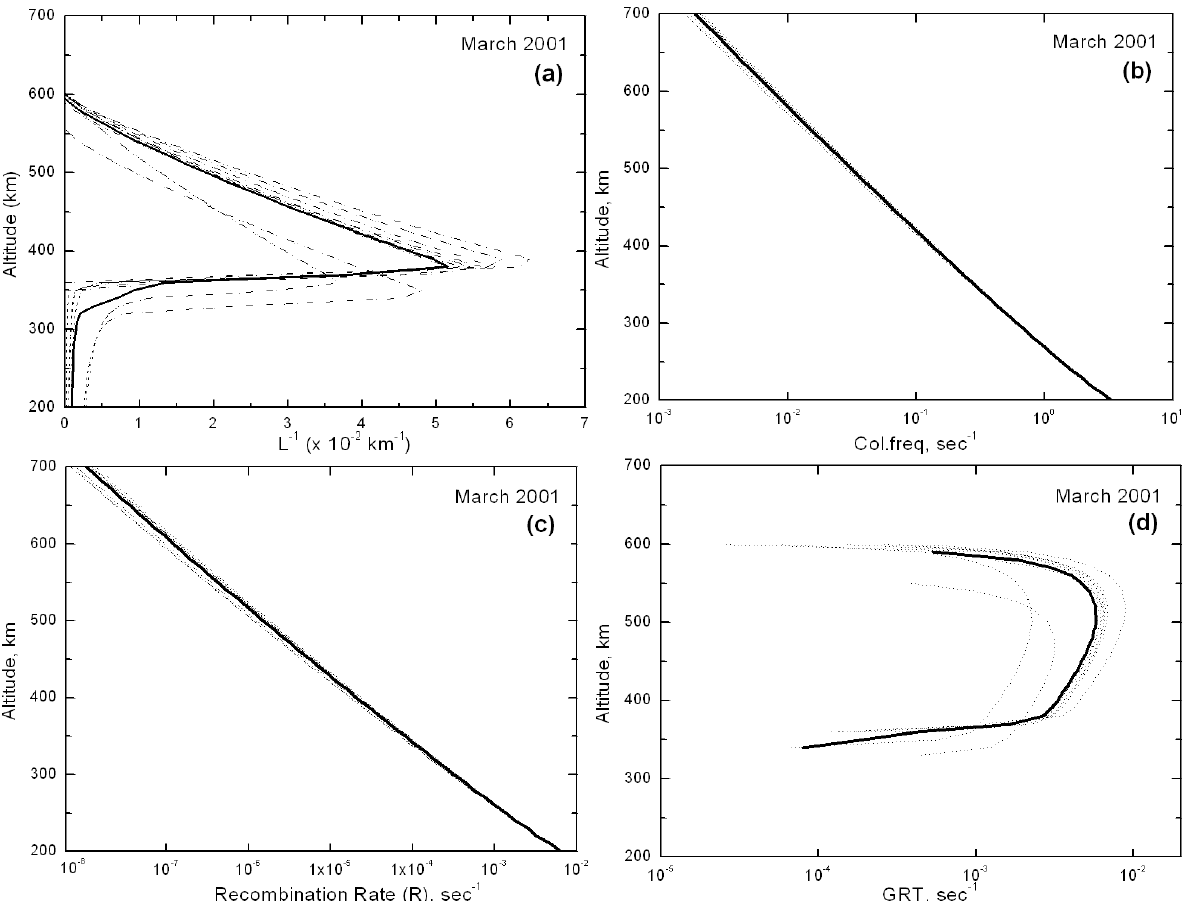
Fig. 5. Altitudinal profiles of (a) inverse density gradient scale length (L − 1 ) , (b) ion-neutral collision frequency ( ν in ) , (c) recombination rate ( R ) and (d) the linear growth rate of CR-T instability ( γ) at 19:00 LT over Trivandrum during the month of March 2001. The dotted lines are the altitudinal profiles of each day in the month and the solid line represents the monthly mean altitudinal profile for the month of March